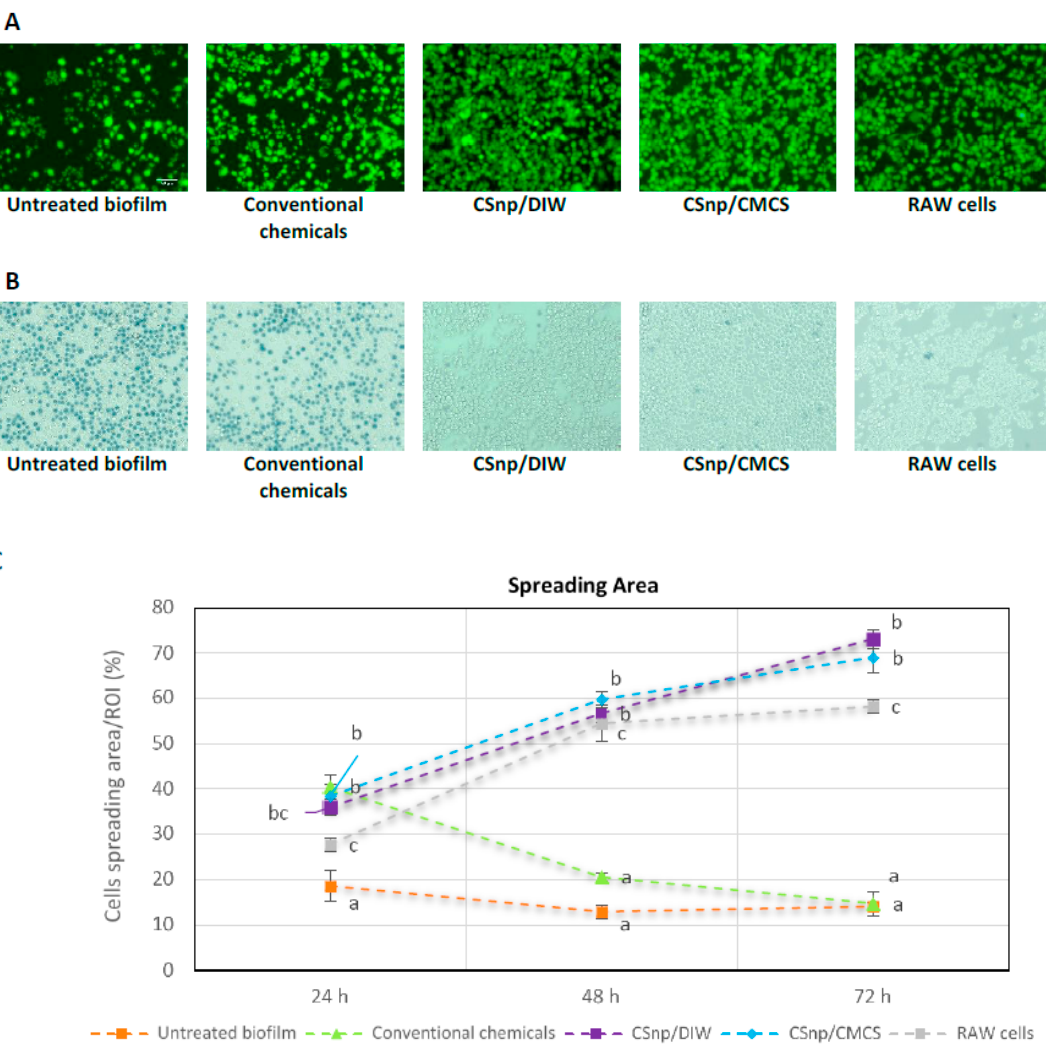
Figure 6. ( A ) Fluorescent images of Calcein AM stained RAW264.7 macrophages showing relative viability of cells after 72 h of interaction, (20 × magnification, scale bar = 50 µ m). ( B ) Microscopic images showing trypan blue exclusion assay performed to check cells viability in di ff erent treatment groups. ( C ) Spreading area of live macrophages in regions of interest (ROI) in treatment groups showing highest percentage of spreading in both CSnp treated groups. Error bars represent standard error of the mean, di ff erent characters above bars indicate statistically significant di ff erence between the groups at each time point ( p < 0.01).